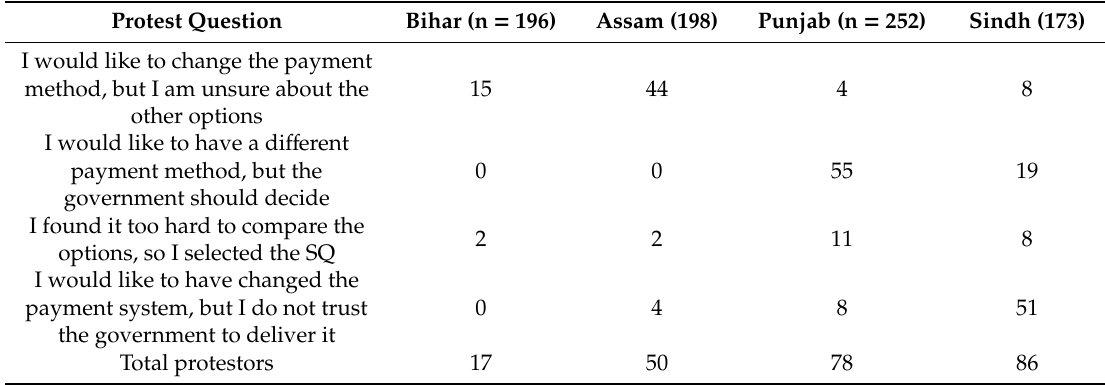
Table 5. Number of “protest” respondents, and reasons given for behaviour, by